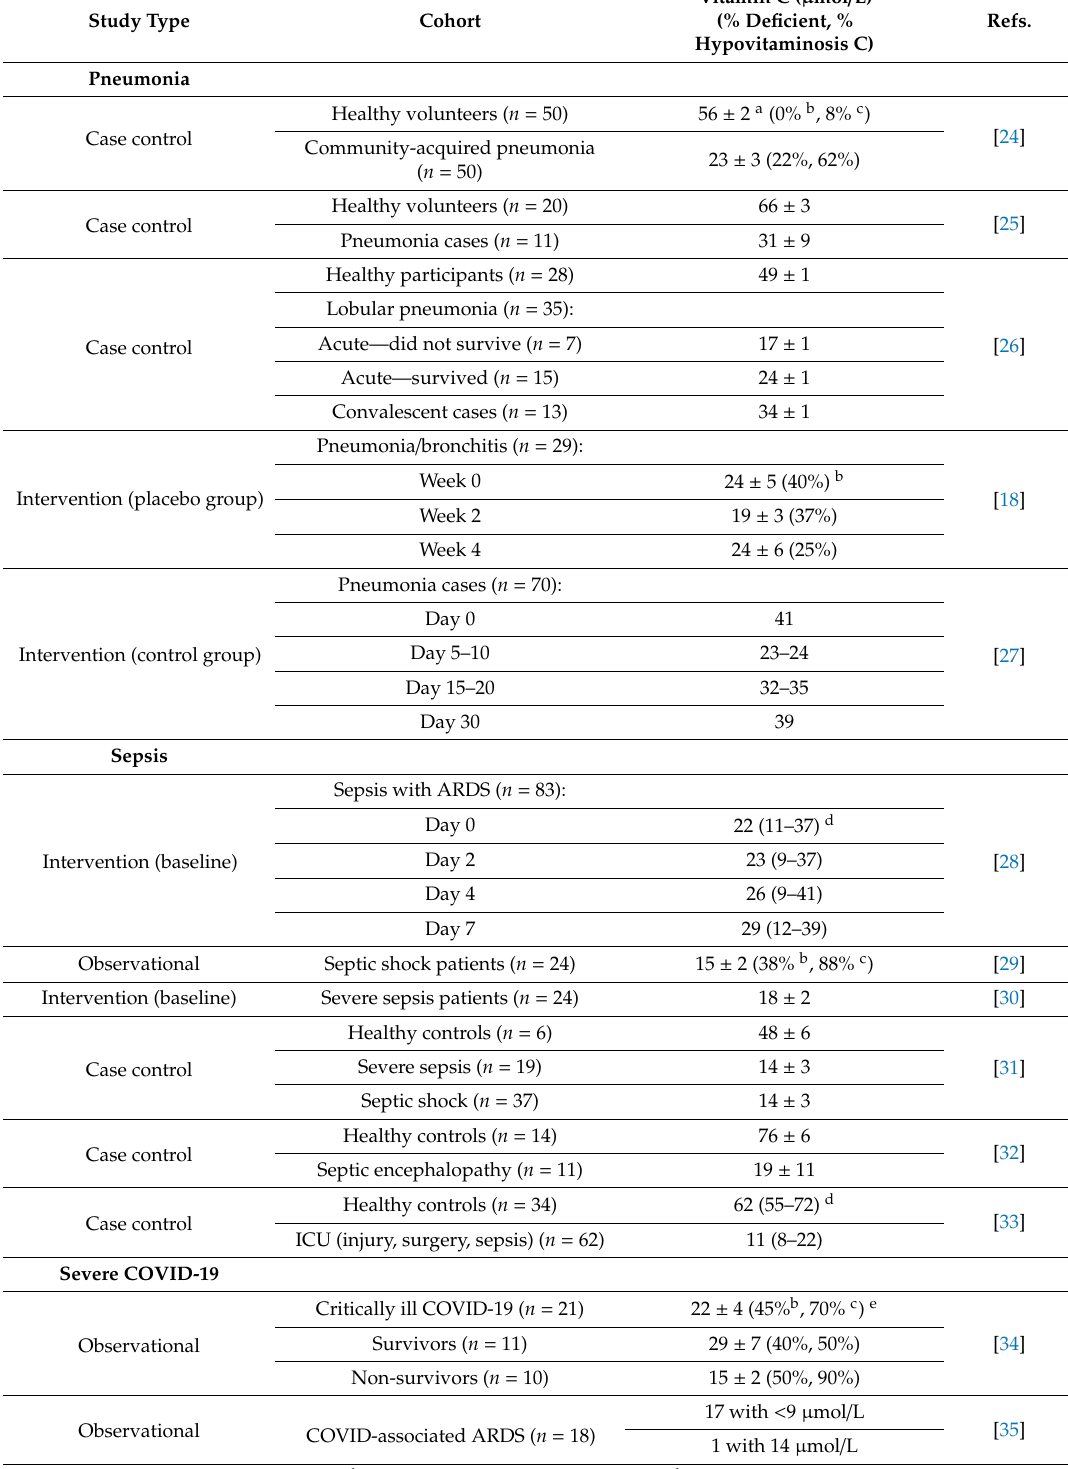
Table 1. Vitamin C status of patients with pneumonia, sepsis and severe